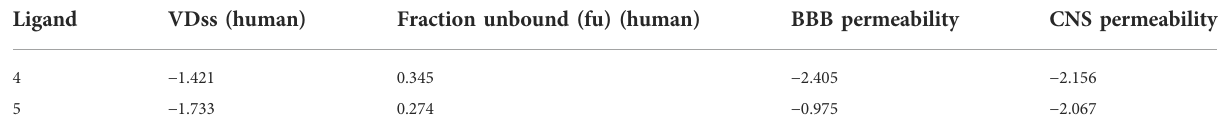
TABLE 7 The distribution pro fi le evaluation results of the hits.